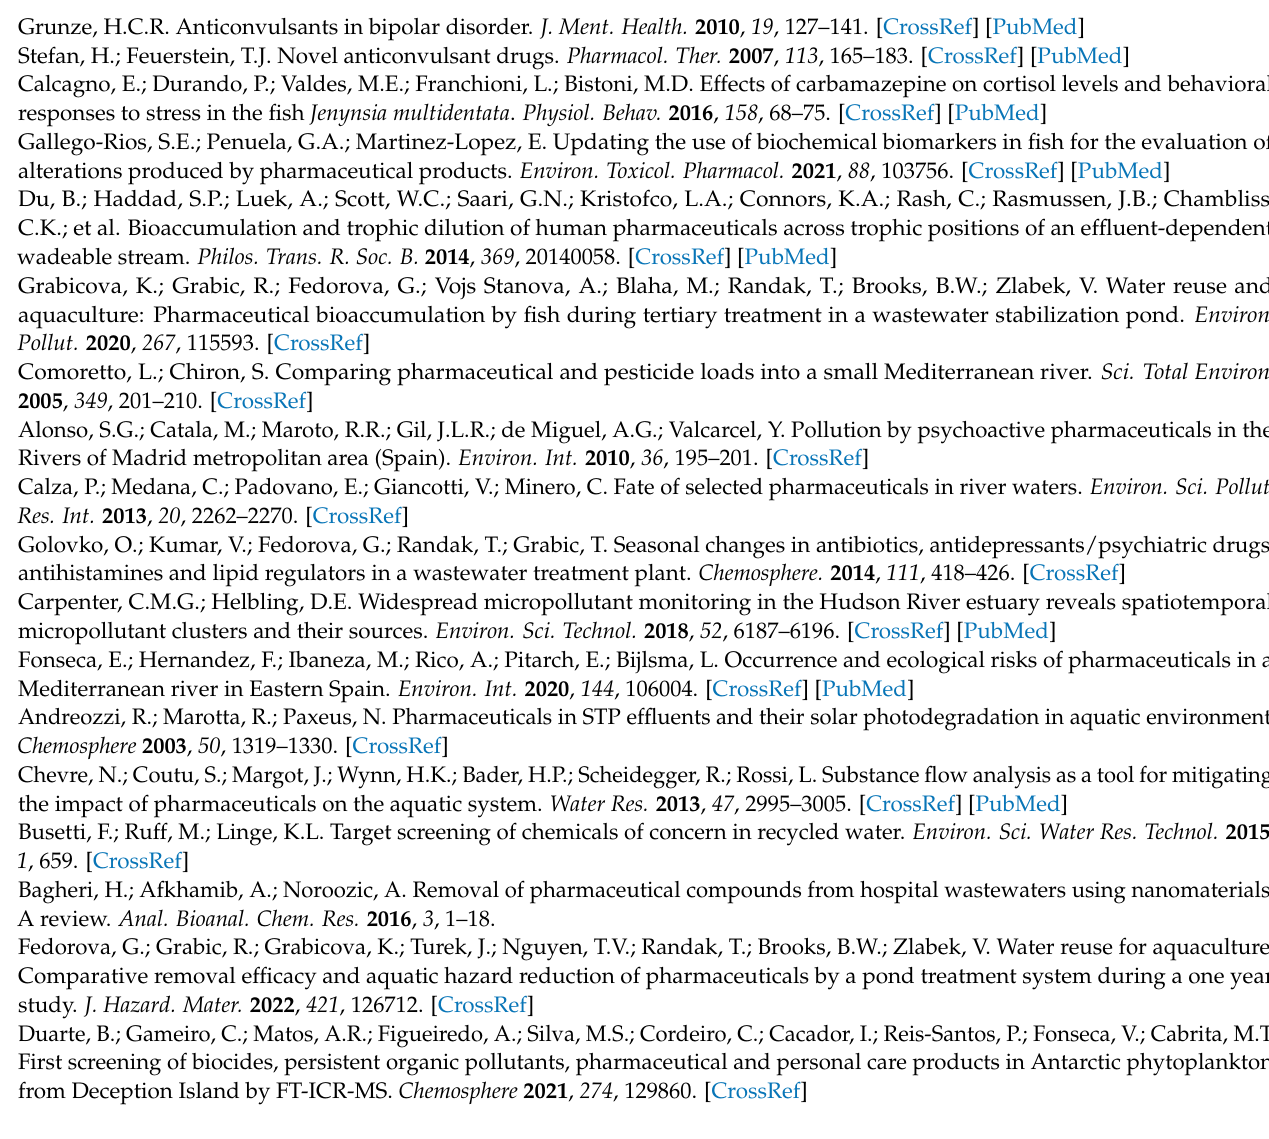
Table S1: List of most important wastewater treatment plants located upstream from indicated sampling